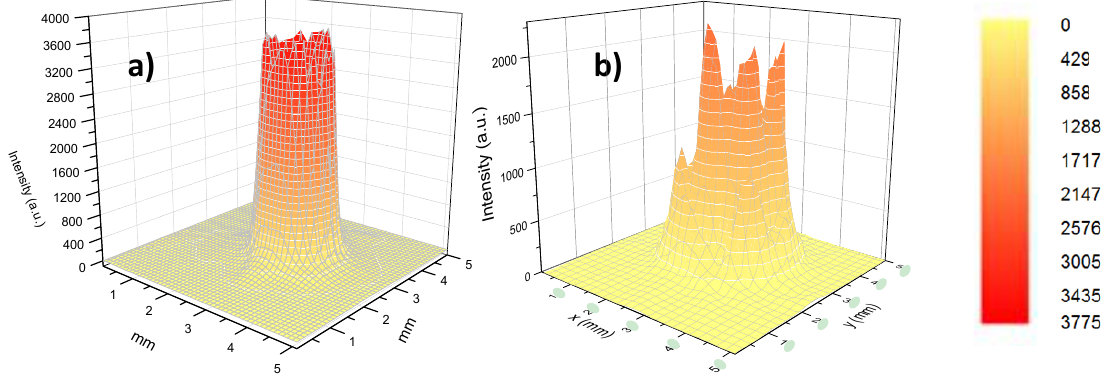
Figure 8. Far-field spatial intensity distribution upon exiting a 12 cm long and 1 mm bore diameter hollow waveguide having a single dielectric film of AgI and Ps at L = 5.1 cm ( b ) distance from the waveguide exit. L 2